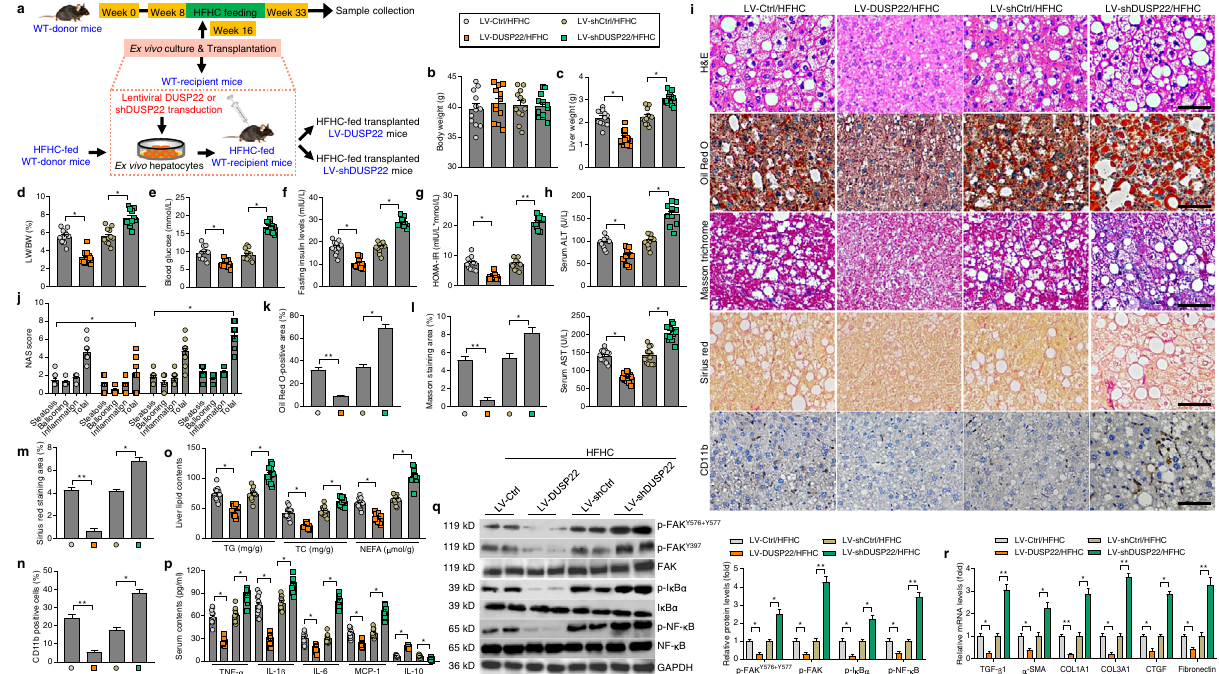
Fig. 7 | DUSP22 protects against HFHC-induced NASH pathologies. a Scheme showing the ex vivo-regulated gene therapy. Primary hepatocytes from the pre- conditionedWT mice fedwithan8-weekHFHCas donor wereisolated and ex vivo cultured. The cultured hepatocytes were then transduced with